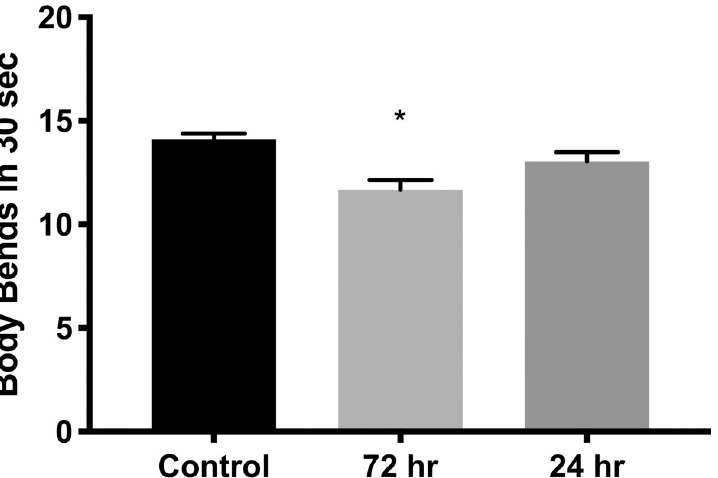
Fig 4. Locomotion is impaired by exposure to “T+S”. Total number of full sinusoidal body bends performed by individual worms in 30 seconds. Worms were raised on standard NGM plate plates for 72 hours to early L4 stage (“T +S from egg”) and then either transferred to new control plates (“Control”) or 1X “T+S” (“Treatment”) for 72 hours to early L4 stage. L4 worms raised on control plates for 72 hours were transferred to new control plates or ones pretreated with 1X “T+S” for 24 hours. L4 worms raised on plates pretreated with “T+S” for 72 hours were transferred to control plates for 24 hours. “T+S” was found to significantly decrease locomotion when worms were exposed to “T+S” from egg stage, but not from young L4 stage (“T+S from L4”) ( p = 0.0003, 0.5793, respectively). Data shown are average ± SEM of 45–100 worms in each group; � p < 0.001 when compared with control using one-way ANOVA.